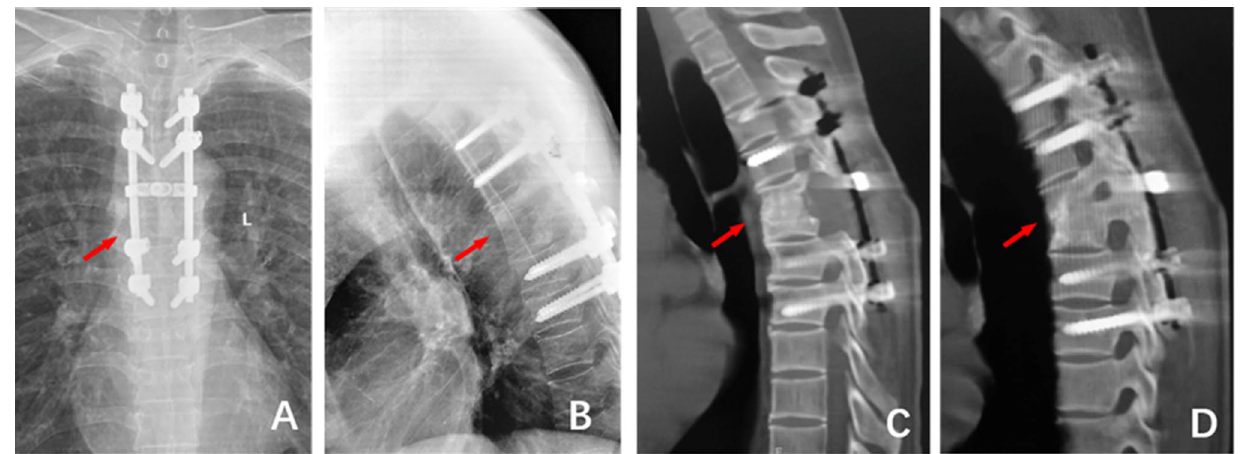
Figure 3. 5 years after the operation, ( A )and ( B ) The frontal and lateral X-ray films showed good internal fixation position, bone graft fusion, and Cobb Angle of 20°; ( C ) and ( D ): CT examination showed good internal fixation position and bone graft